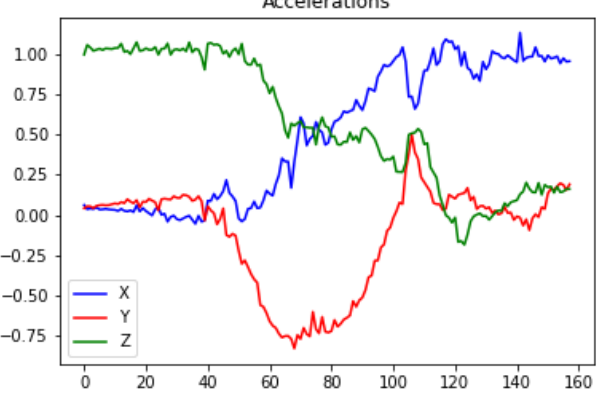
Figure 9. Accelerations of the users getting out of bed from